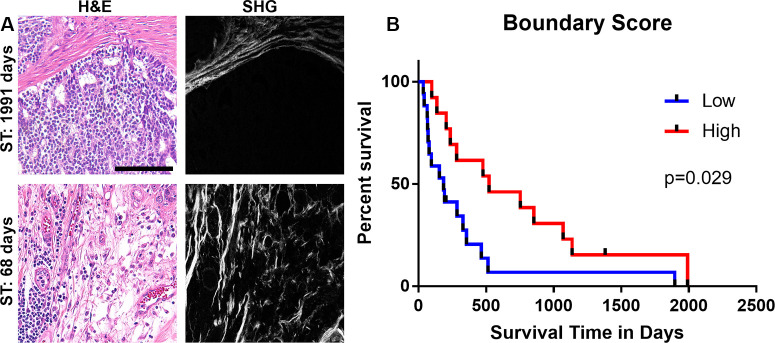
Absence of a tumor-stromal boundary predicts poor outcome in feline mammary tumors.(A) H&E and corresponding SHG (collagen, white; from serial sections) in representative images of tumors obtained from a long-lived patient (ST = 1991 days) with a high boundary score (A; top) and from a short-lived patient (ST = 68 days) with a low boundary score (A; bottom). Six observers graded each image as either (1) discrete tumor-stroma boundaries were the principal pattern observed or (0) tumor-stromal boundaries were not the principal pattern. The boundary score is the average evaluator score for each image, averaged for each tumor. (B) Kaplan-Meier survival curve for 30 cats with boundary scores higher or lower than the mean boundary score. Univariate cox regression was used to evaluate whether the boundary score significantly impacted survival (p = 0.029, hazard ratio 0.385, 95%CI 0.164–0.906). All images in figure are at the same scale. Scale bar: 100μm.